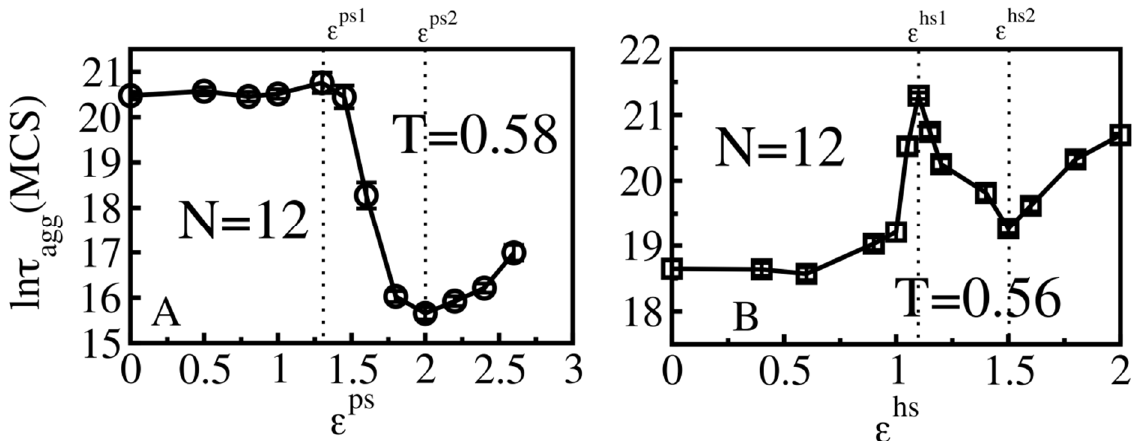
Figure 7. Effect of various surfaces on the aggregation time of N = 12 polypeptide chains at T = 0.58 for smooth hydrophilic surfaces ( A ) and at T = 0.56 for hydrophobic surfaces ( B ). The dash lines at values ε ps1 = 1.3, ε ps2 = 2.0, ε hs1 = 1.1 and ε hs2 = 1.5 separate the different interaction ranges corresponding to different types of classified surfaces.